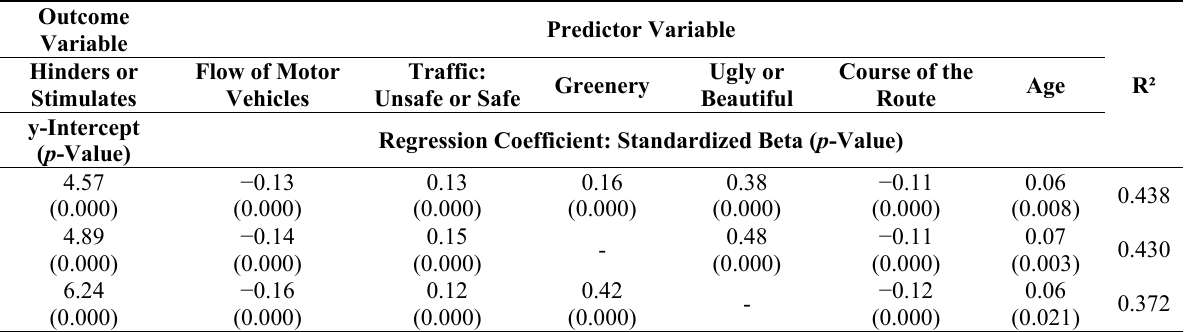
Table 8. Sensitivity analyses of Model 2 (n =